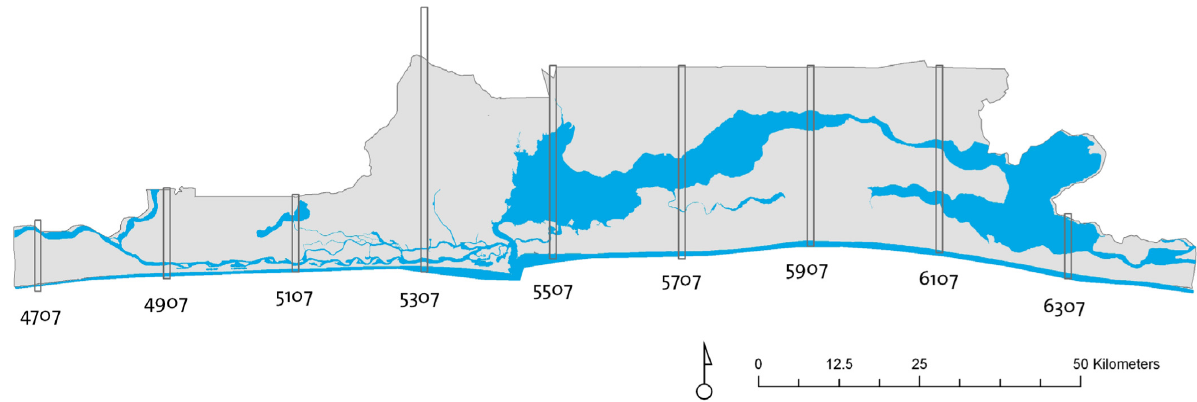
Figure 5. Strips of data tiles were selected because the full dataset for the Lagos State area was too extensive.